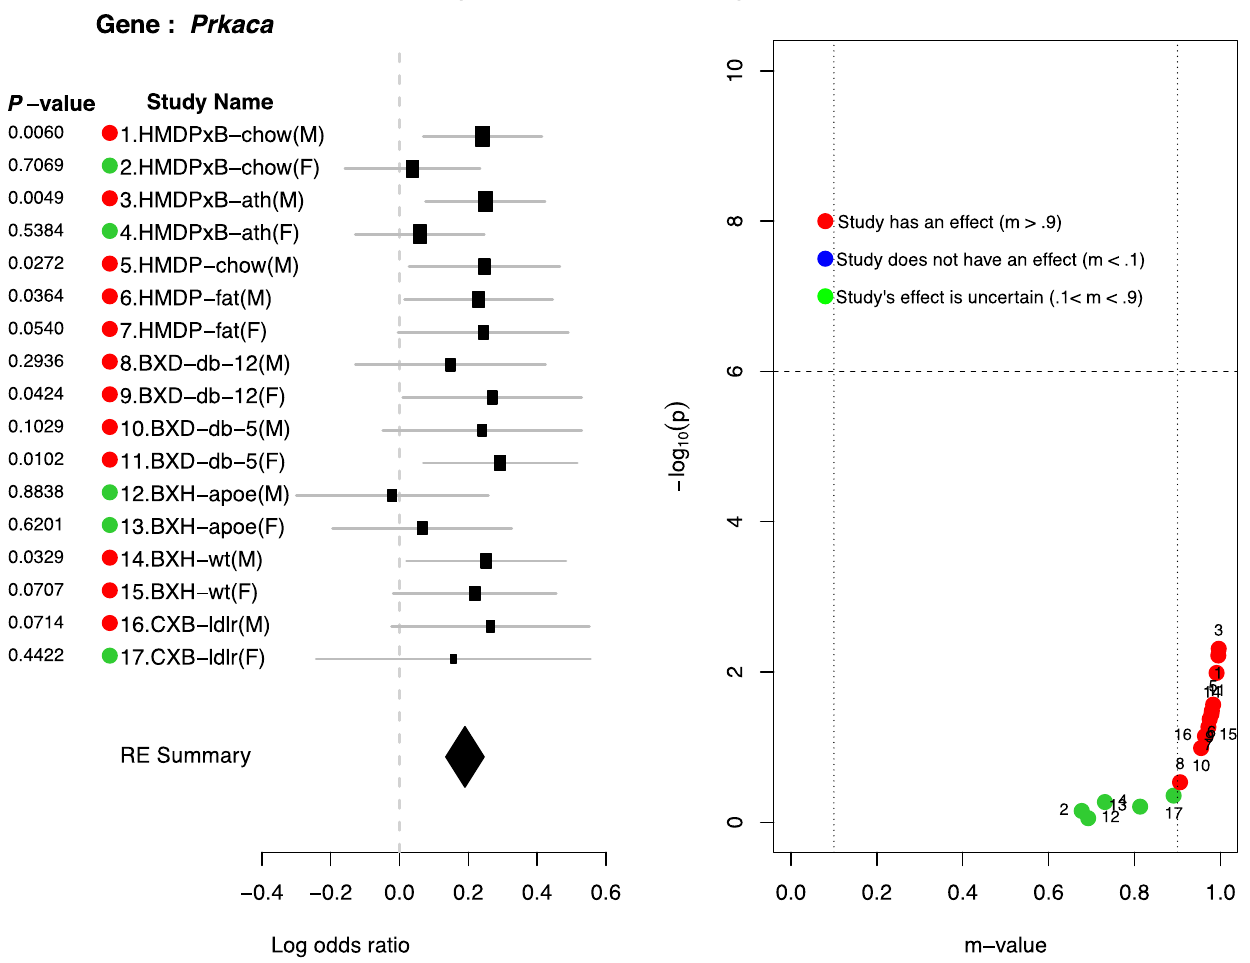
Figure 6. Peak SNP in chromosome 8 shows interesting gene-by-environment interactions between sex 6 mutation-driven LDL levels.